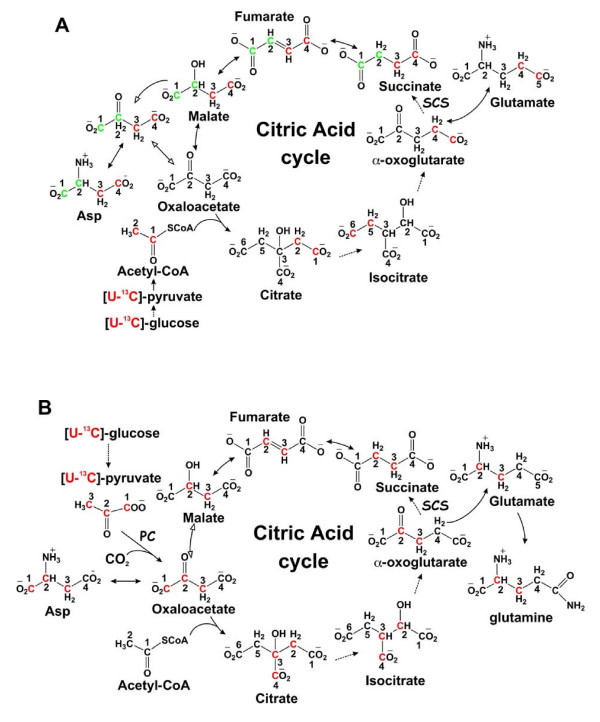
13C labeling patterns in products of glycolysis, PPP and mitochondrial Krebs cycle with [U-13C]-Glc as tracer. The Krebs' cycle reactions are depicted without (panel A) or with (panel B) anaplerotic pyruvate carboxylation (PC) and the labeling patterns illustrated represent one turn of cycle activity. Two distinct 13C labeling patterns in Glu result from the cycle reactions with (panel B) or without PC (panel A), i.e. 13C labeling at C2,3 or C4,5, respectively. Isotopic scrambling occurs at the symmetric succinate, leading to the redistribution of 13C labels into C1 and C2 or C3 and C4 (panel A). Also depicted in panel B is the malate/Asp shuttle across the mitochondrial membrane, where the export of [13C-1,2,3]-Asp into the cytosol leads to the synthesis of [13C-1,2,3]-malate. Red C and green C represent 13C labeled carbons; solid and dashed arrows denote single and multi-step reactions, respectively; open arrows in panel A delineate unlabeled starting oxaloacetate (OAA) from 13C-labeled OAA after one turn; open arrow in panel B denotes the start of a second cycle; double headed arrows indicate reversible or exchange reactions; SCS denotes succinyl CoA synthetase.